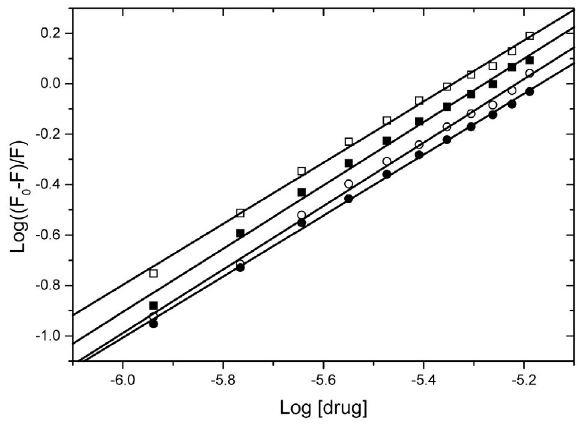
Figure 6. The Stern–Volmer plots for the binding of nandrolone de- canoate drug with HSA in presence of [BMIM]PF 6 at 285 K (  ),